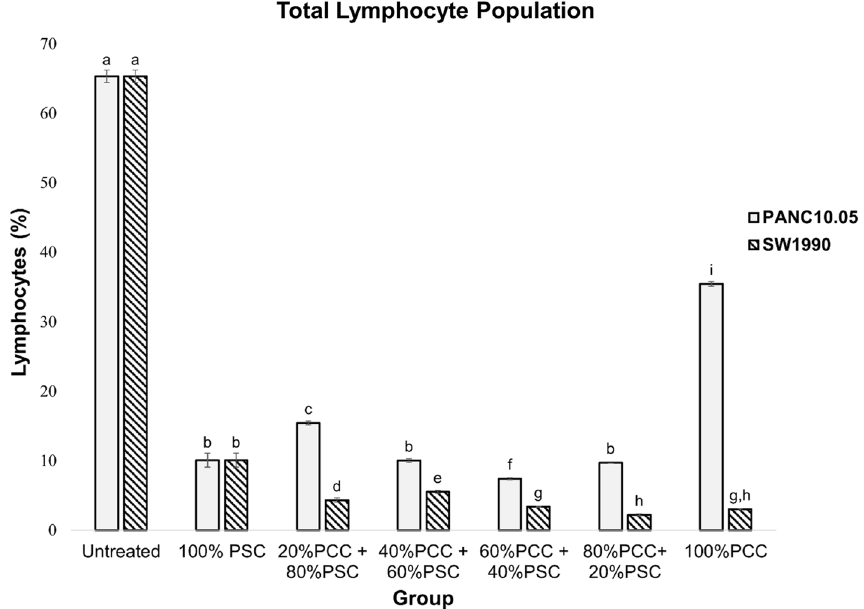
Figure 1. The percentage of lymphocytes in CM treated PBMCs. PBMCs were isolated and treated with medium conditioned by PCCs and/or PSCs for 7 days. Percentage of lymphocytes was determined to verify the lymphocytes suppression of CM on lymphocytes. Statistical significance is indicated by the letters above each column, in which the columns that do not share a common letter have a significance of p ≤